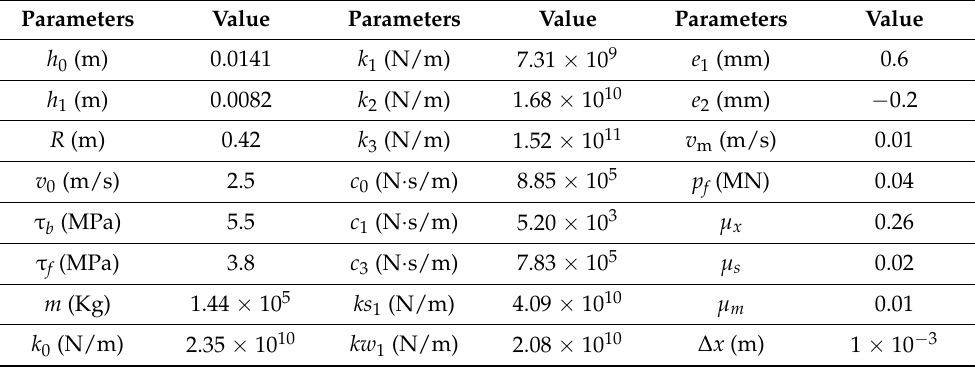
Table 1. Parameters of 1780 mm hot rolling